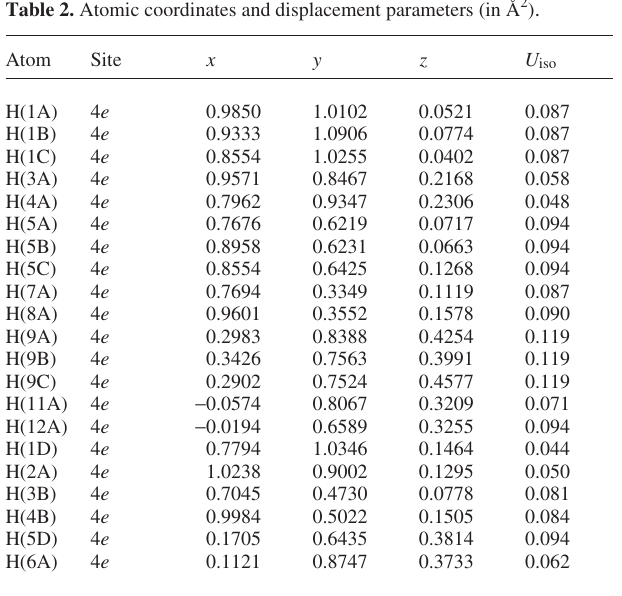
Table 2. Atomic coordinates and displacement parameters (in Å 2 )